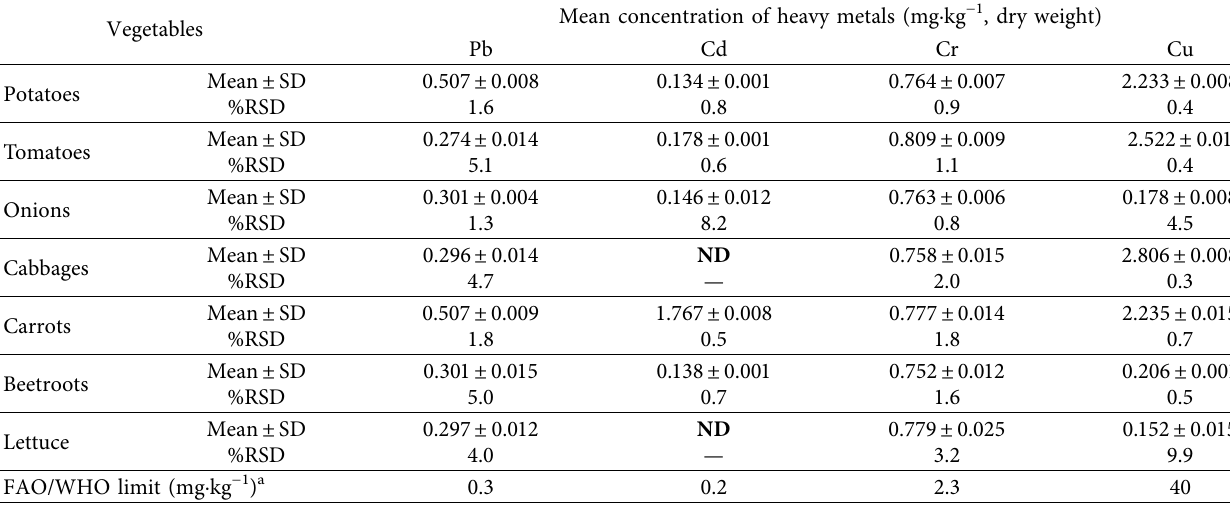
Table 6: Mean concentration of heavy metals in selected vegetables in Bahir Dar town, Northwest Ethiopia (mean ± SD, n � 9).